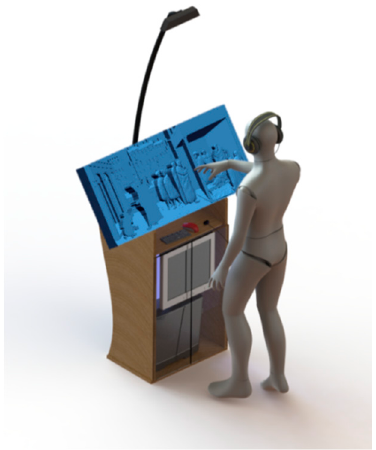
Figure 10. Final layout of the BES prototype.